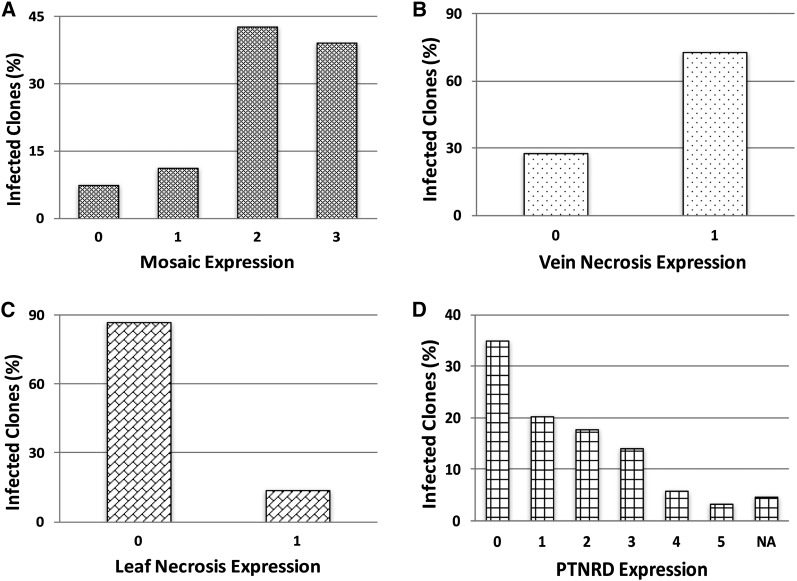
Percentage of Waneta × Pike offspring expressing varying degrees of foliar (A) mosaic, (B) vein necrosis, (C) leaf necrosis, and tuber symptoms (D) (PTNRD). See Figure 1 and Figure 2 for symptom scales. NA, number of clones that did not produce tubers (i.e., PTNRD was not evaluated for them); PTNRD, potato tuber necrotic ringspot disease.